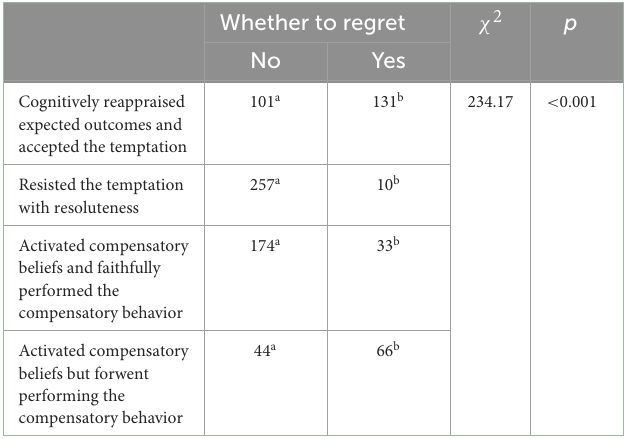
TABLE 1A The descriptive statistics of GBA-IGB for college students ( N = 816).